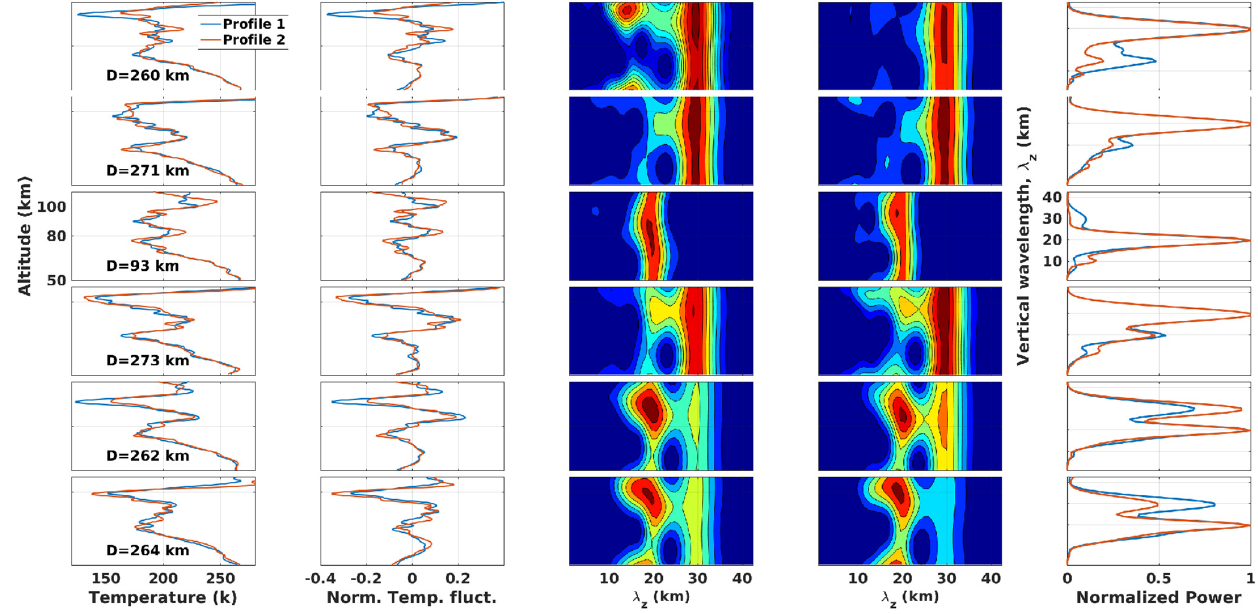
Figure 5. Temperature profiles ( left panels ), normalized temperature fluctuations ( 2nd column from the left ), contour maps of WPS versus vertical wavelength and altitude for the two profiles ( 3rd and 4th columns from the left , deep red and blue colors represent respectively the dominant and lowest power), and normalized GWPS versus vertical wavelength ( right column ) corresponding to six orbits of SABER satellite on 16 October 2011.